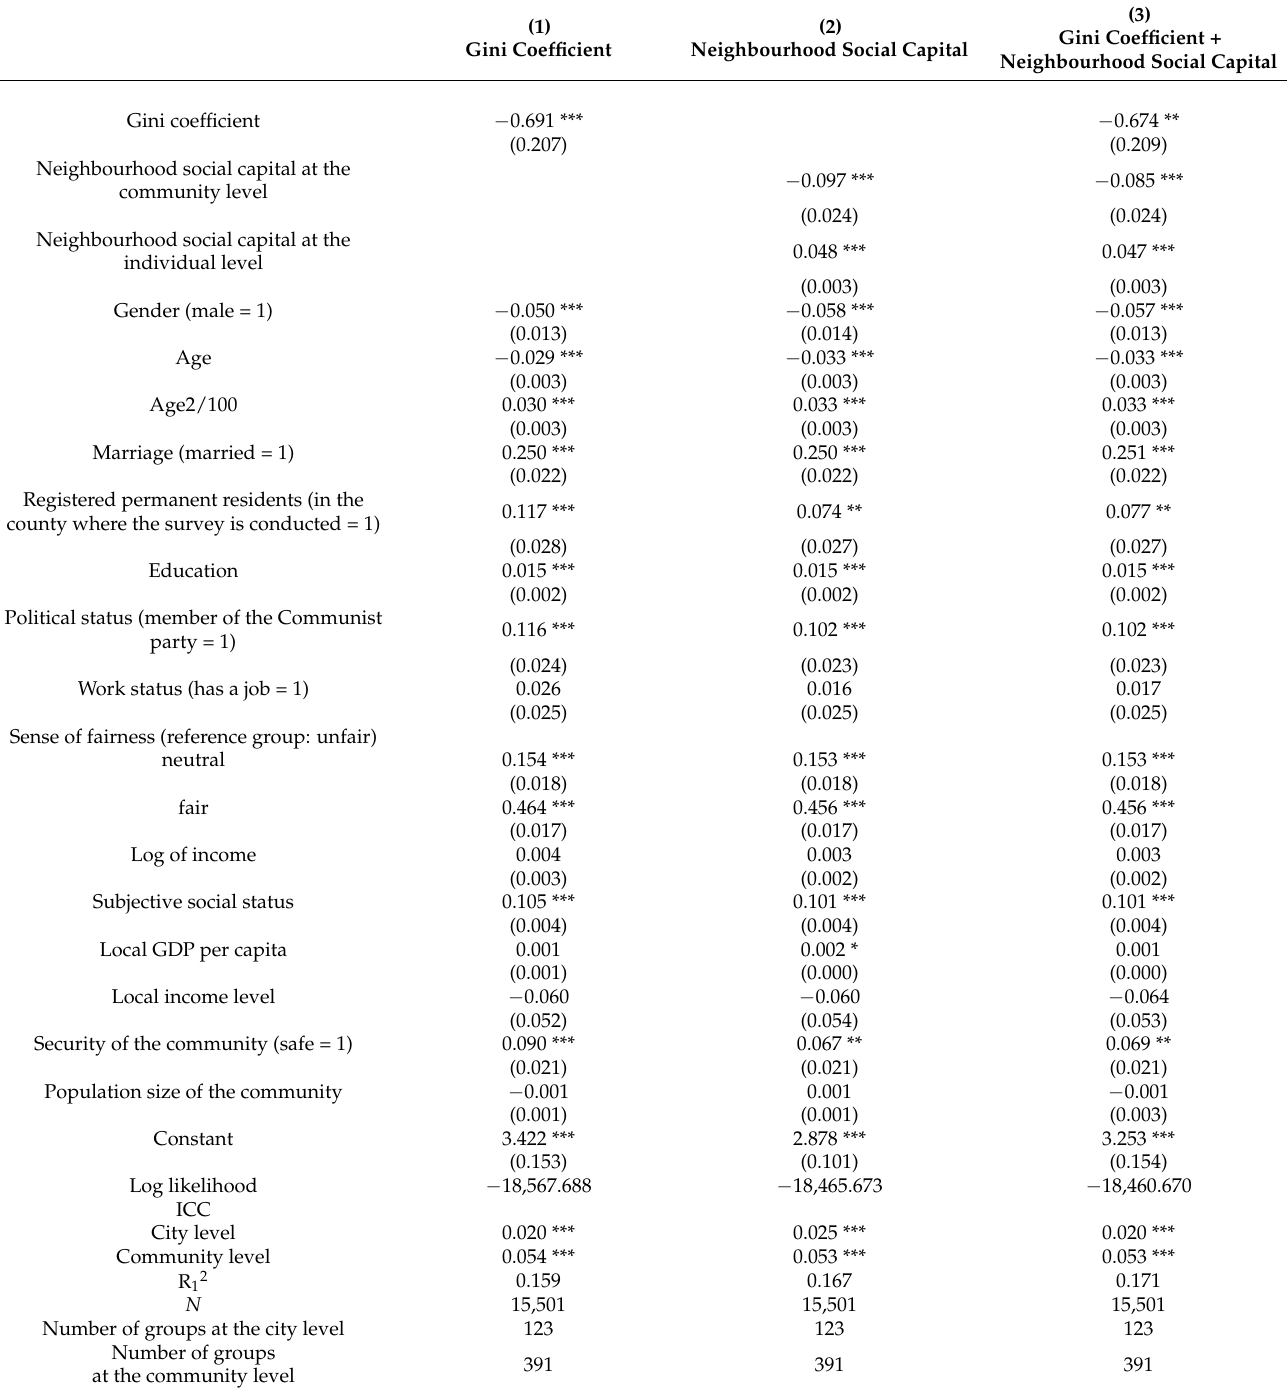
Table 3. The effect of income inequality and neighbourhood social capital on subjective